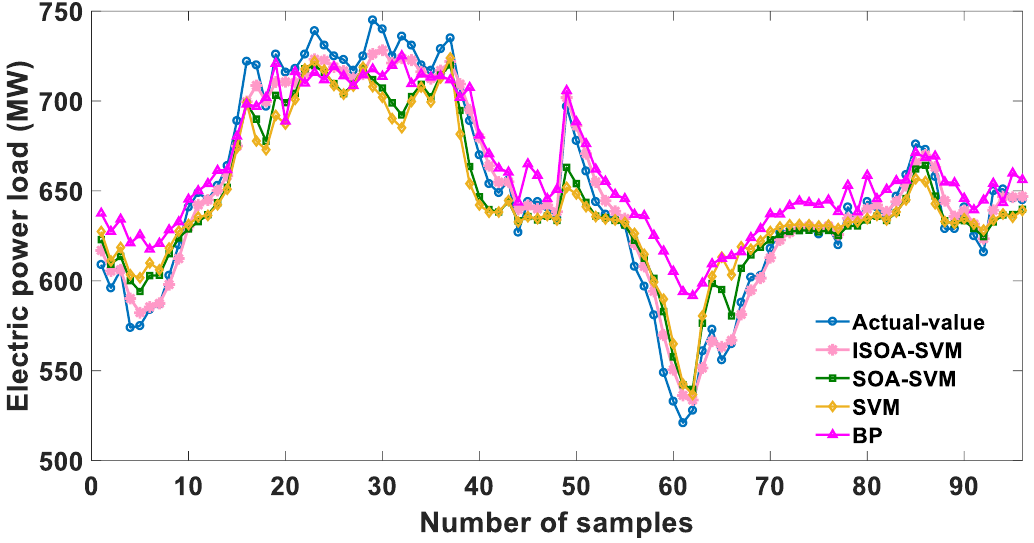
Figure 2. Power load forecasting results of four models for Case 1.